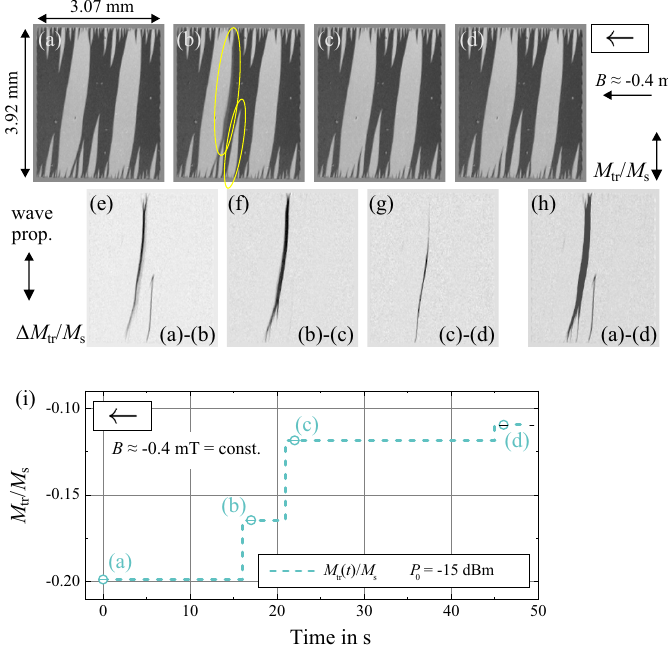
Figure 17. Magnetic domain observations with a constant magnetic bias field of B ≈ − 0.4mT. ( a – d ) Magnetic domain structure over time with an input power of − 15dBm. ( e – h ) Differential domain images displaying the alteration in the magnetic domain states over time. ( i ) Change of the transversal magnetization component M tr / M s with time. The positions of high domain activity are indicated in ( b